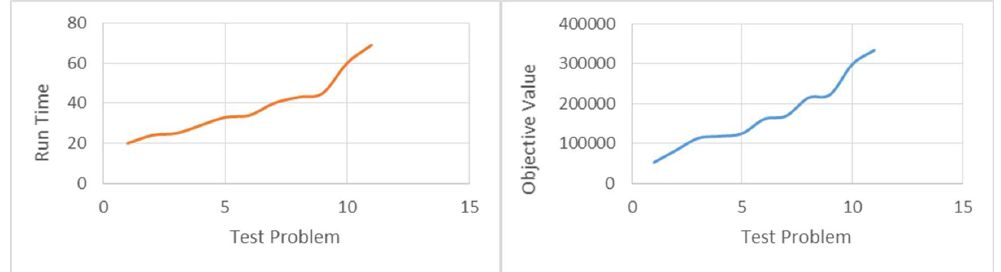
Fig. 10. Objective value and run time for scenario